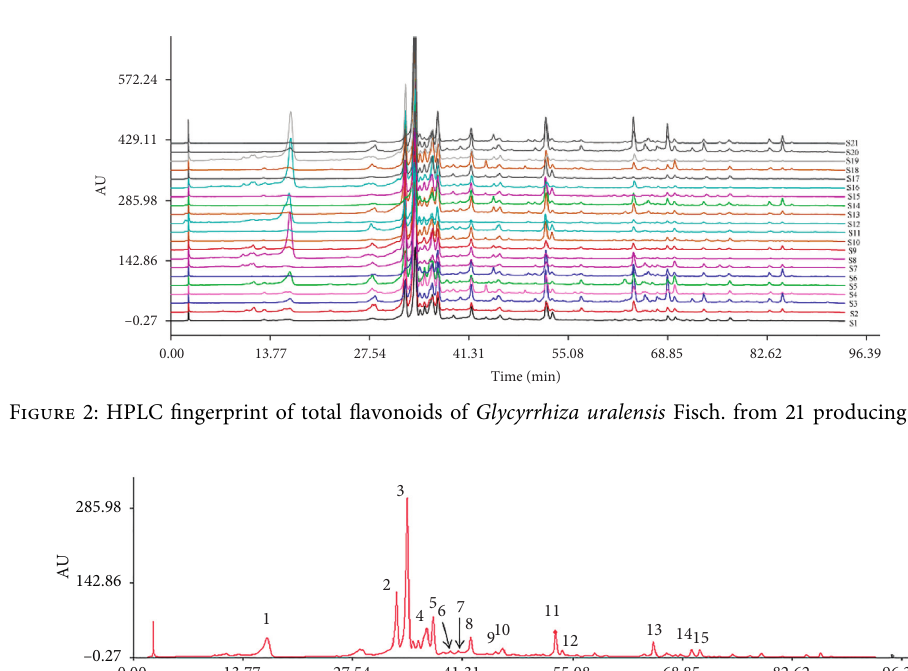
Figure 1: Determination of flavonoids in Glycyrrhiza uralensis Fisch. from 21 producing areas by UV. The result represents mean ± S.D.